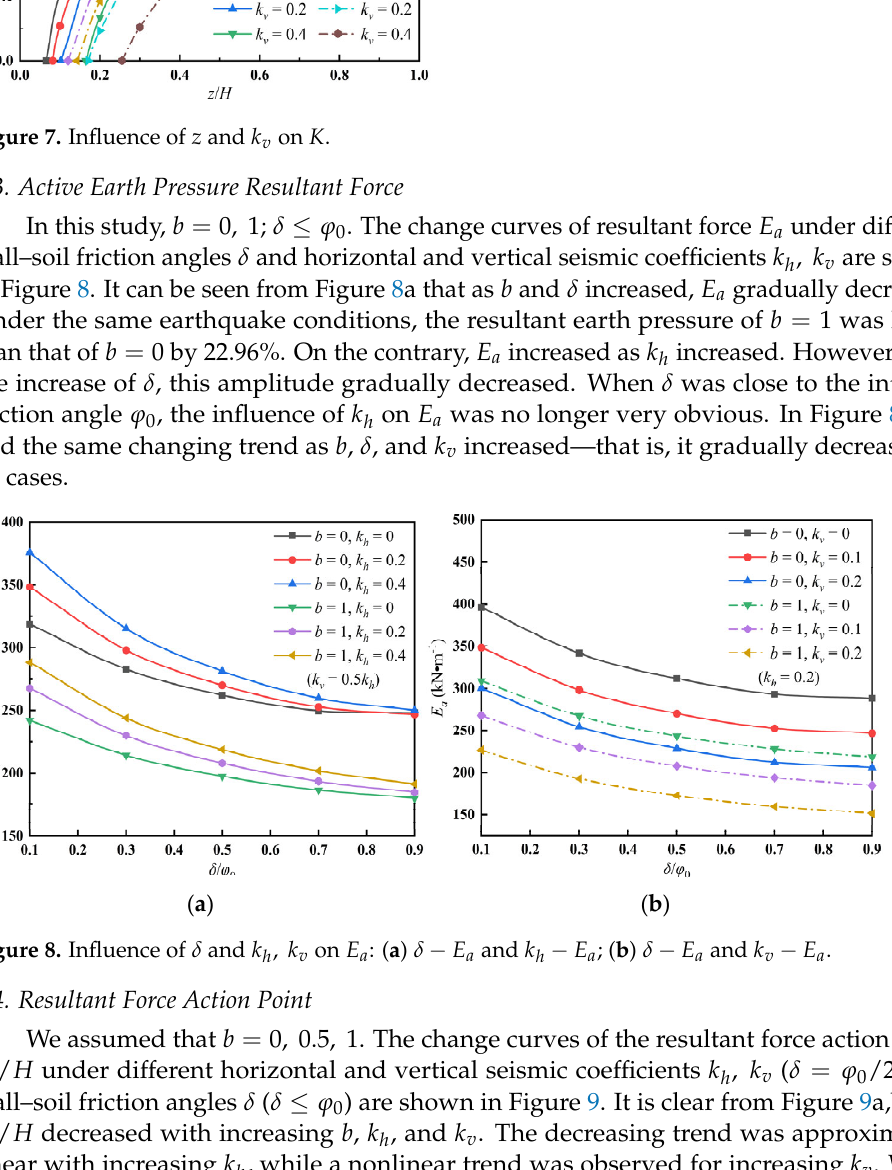
Figure 8. Influence of δ and